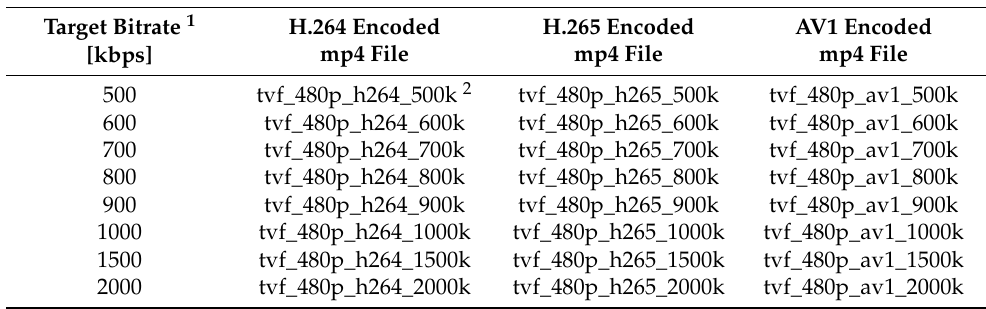
Table 1. The video test